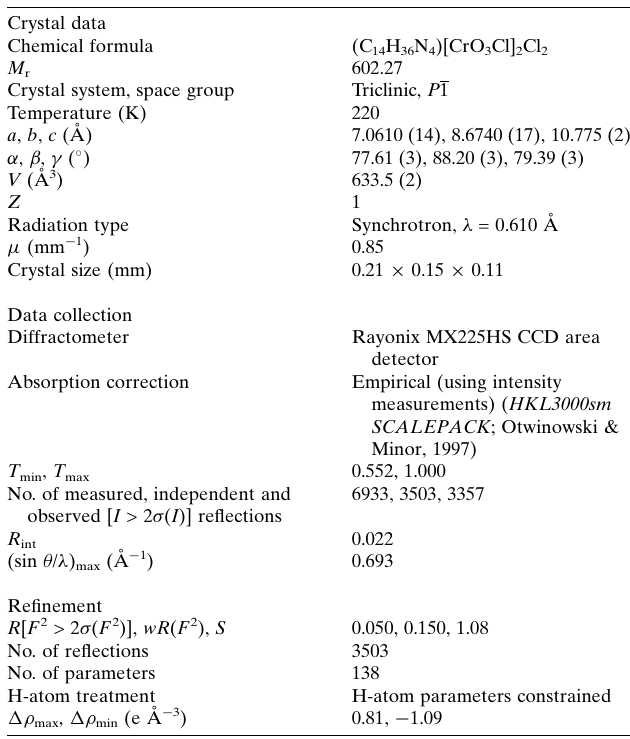
Crystal data Chemical